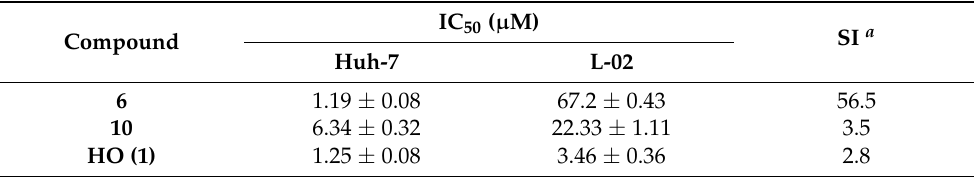
Table 2. Cytotoxicity of compounds 1 , 6 and 10 on L-02 cells.